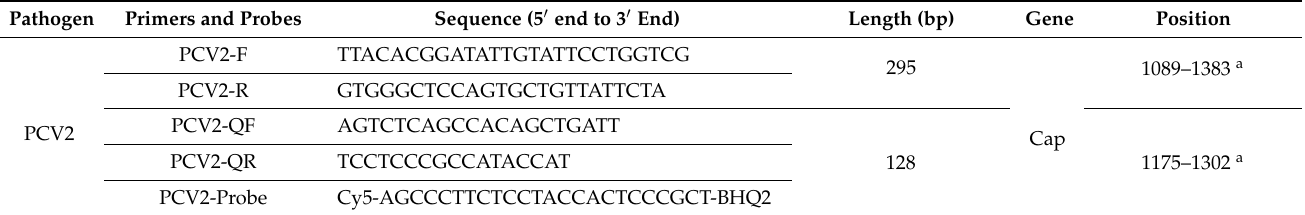
Table 1. Primers and probes used in this